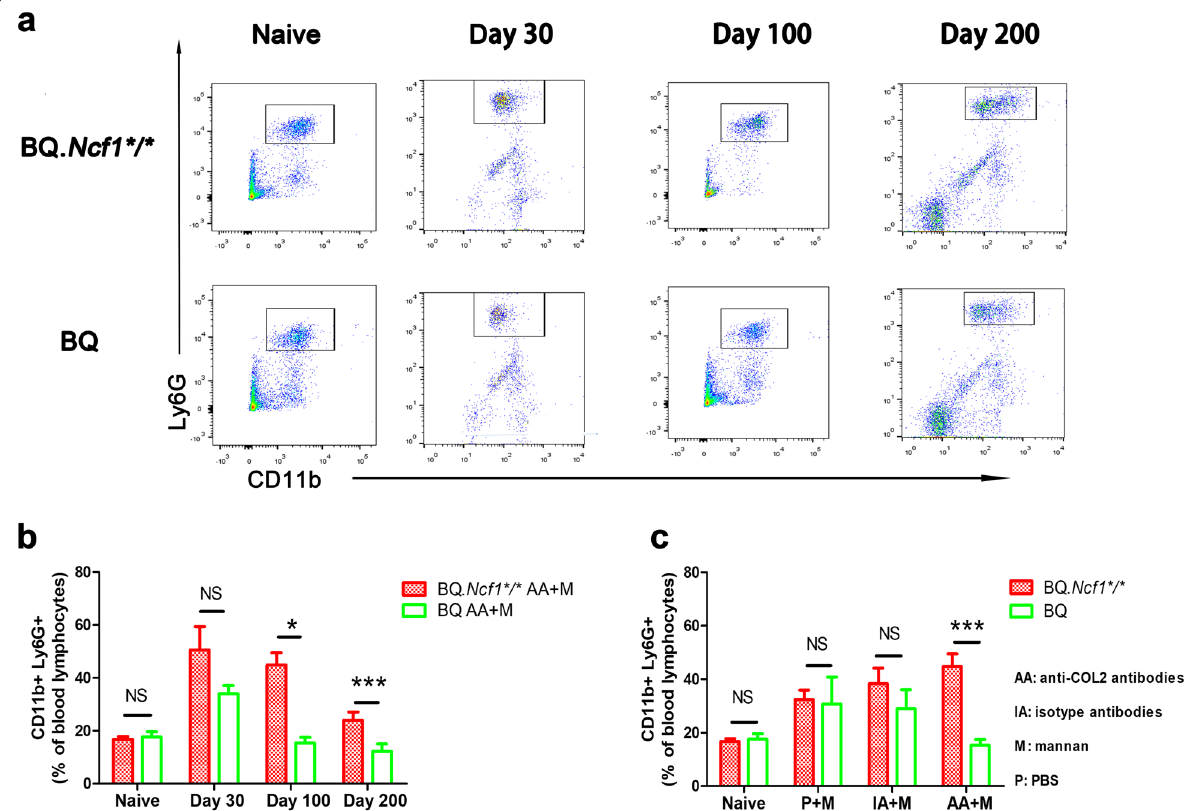
Fig. 4 Increase of neutrophils in the chronic phase of mCAIA in BQ. Ncf1 */* mice. FACS was performed using the blood lymphocytes on days 0 (naive) ( n 6–8), 30, 100 ( n 8–10) and 200 ( n 3–4). a Flow cytometry scatter plot. b Comparison of percentage of CD11b + Ly6G + cells present = = = in the blood between BQ. Ncf1 */* mice and BQ mice on different days. c The percentage of CD11b + Ly6G + cells present in the blood samples from different groups on day 100. The data shown are mean SEM. The two-tailed Mann-Whitney U test was used to calculate the level of significance. ± BQ. Ncf1 */* AA M vs BQ AA M: *, p < 0.05, **, p < 0.01, ***, p < + +